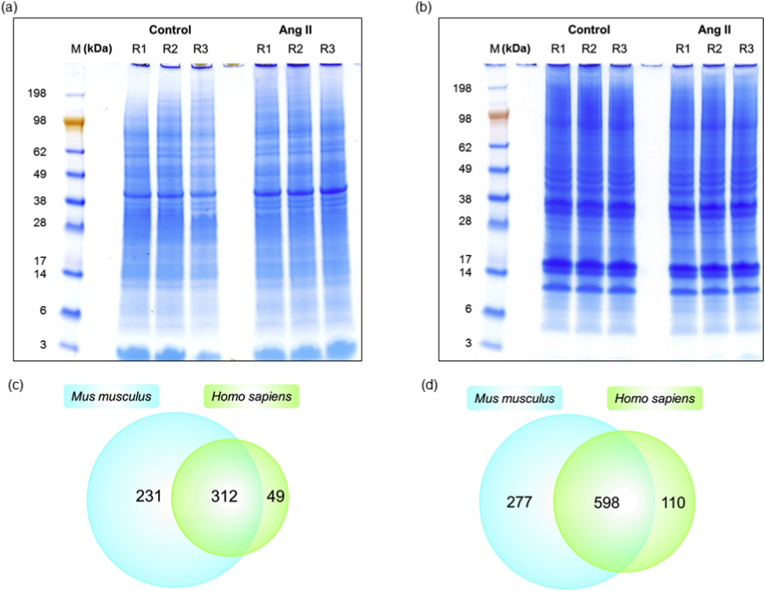
Proteome of ophthalmic artery and retina. (a) Representative protein profiles of (a) ophthalmic artery and (b) retina subjected to Ang II and vehicle resolved in 1DE gel and stained with Colloidal blue. Venn diagrams depict the total number of proteins identified in both mouse and human databases in the (c) ophthalmic artery and (d) retina. M: Marker; R1-R3 represent three biological replicates. (For interpretation of the references to colour in this figure legend, the reader is referred to the Web version of this article.)